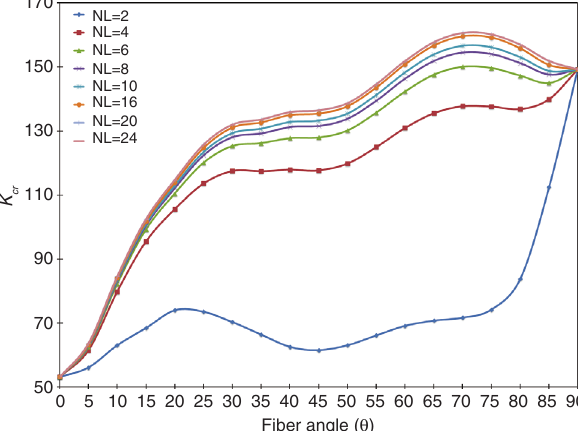
Figure 9 Critical buckling load parameter for simply supported antisymmetric cylindrical skew panel (Ø = 30 ° , α = 30 ° ).